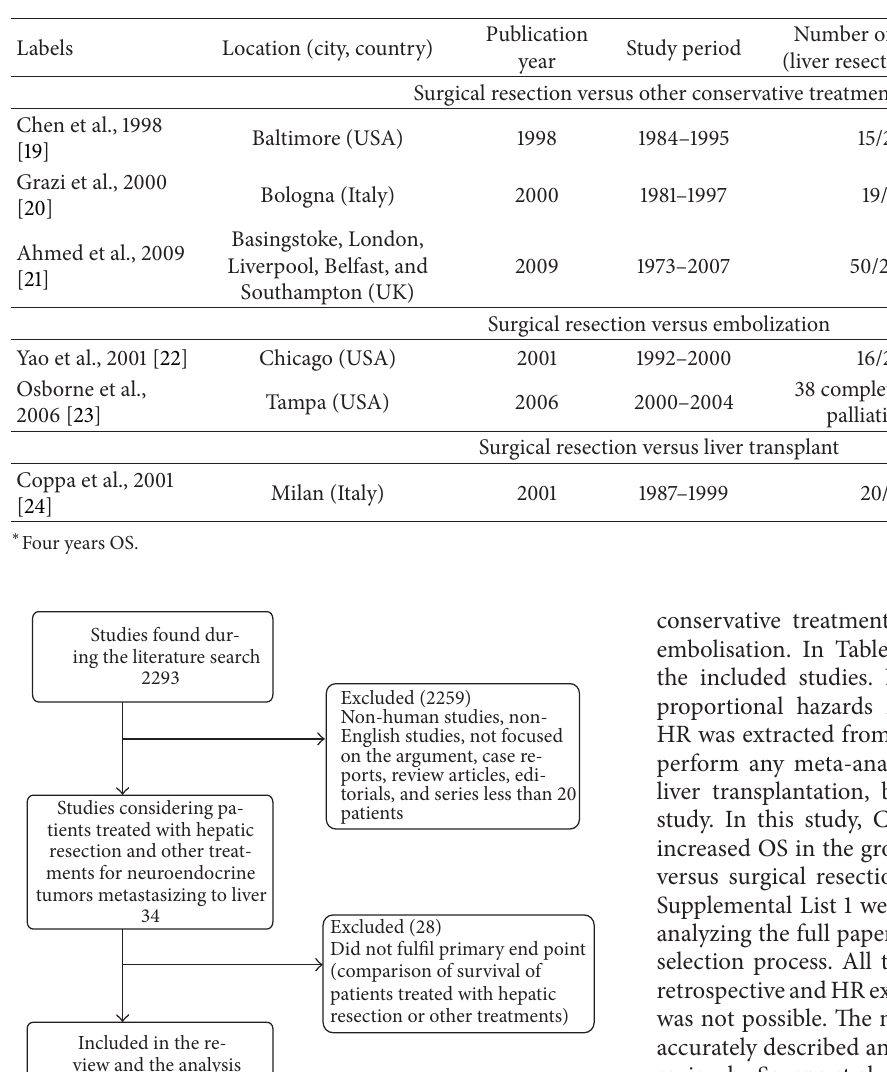
Table 1: Description of the included studies.